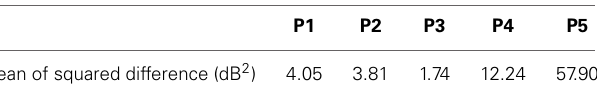
Table 7 | Mean of squared difference between ISD-difference curves for the five HPDs (Figure